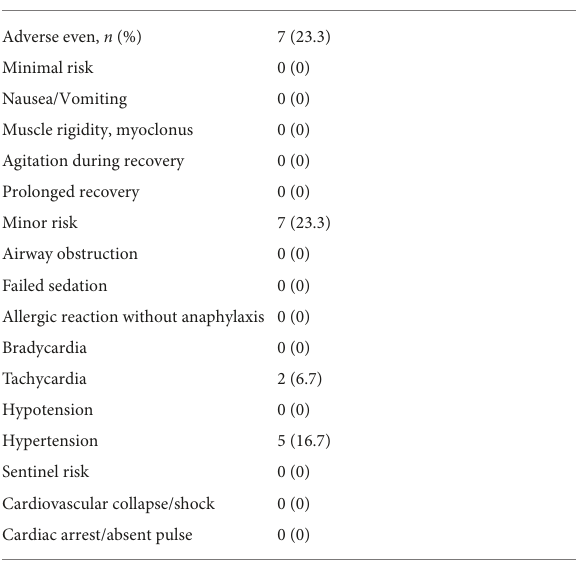
TABLE 6 Other adverse events related to the sedation ( n = 30).